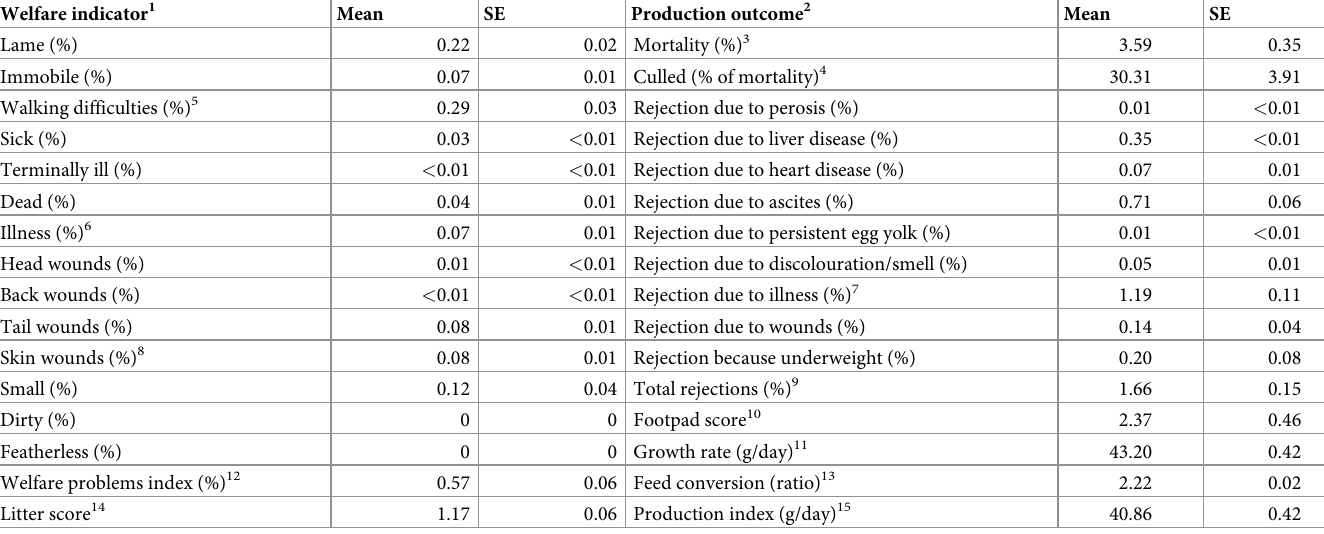
Table 3. Prevalence of welfare problems detected by transect sampling during on-farm welfare assessment, and production